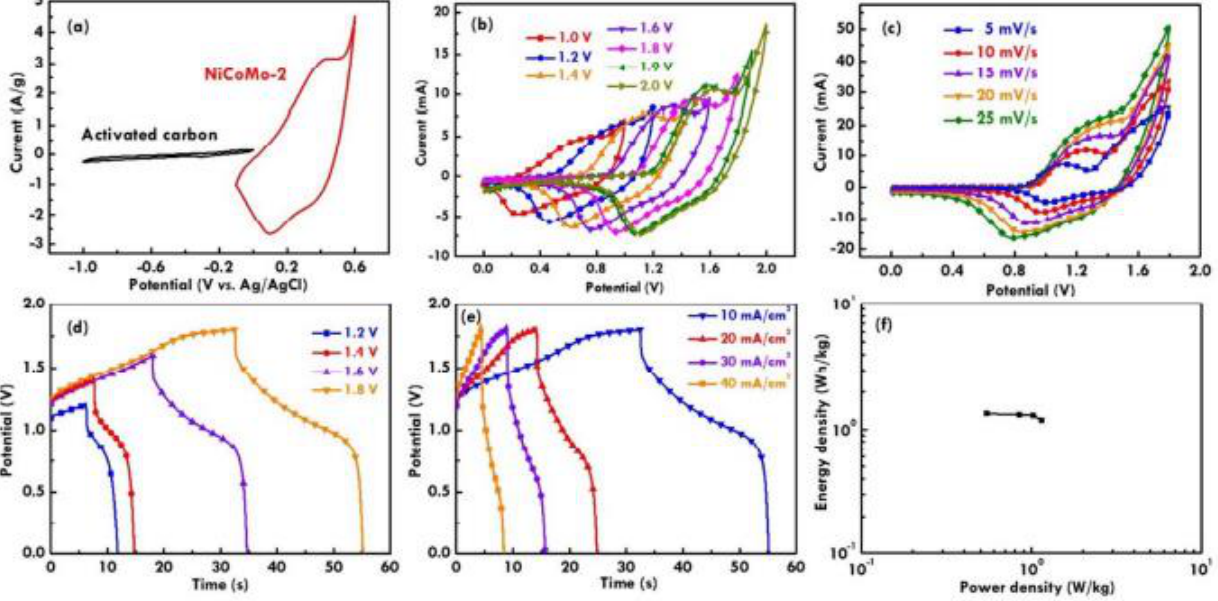
Figure 11. The current-potential curves for ( a ) the anodes and cathodes, ( b ) the current-potential curves measured using several potential windows, ( c ) different scan rates, ( d ) the GC/D plots measured using several potential windows, ( e ) different current densities, and ( f ) the Ragone plot of the BSH. Reprinted with permission from [111]. Copyright 2018 American Chemical